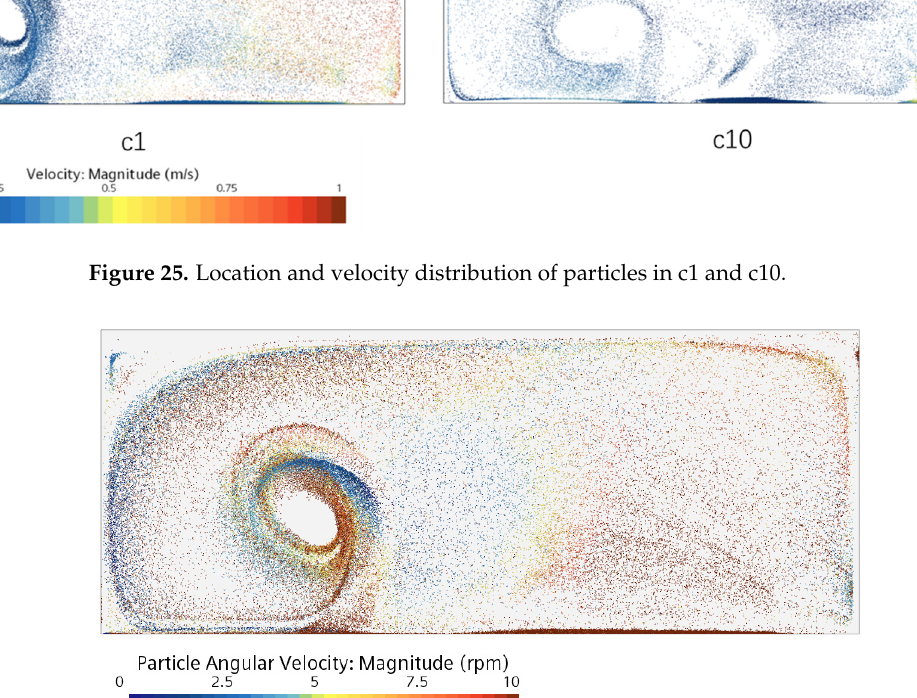
Table 2. Summary and comparison of distribution uniformity. Uniformity